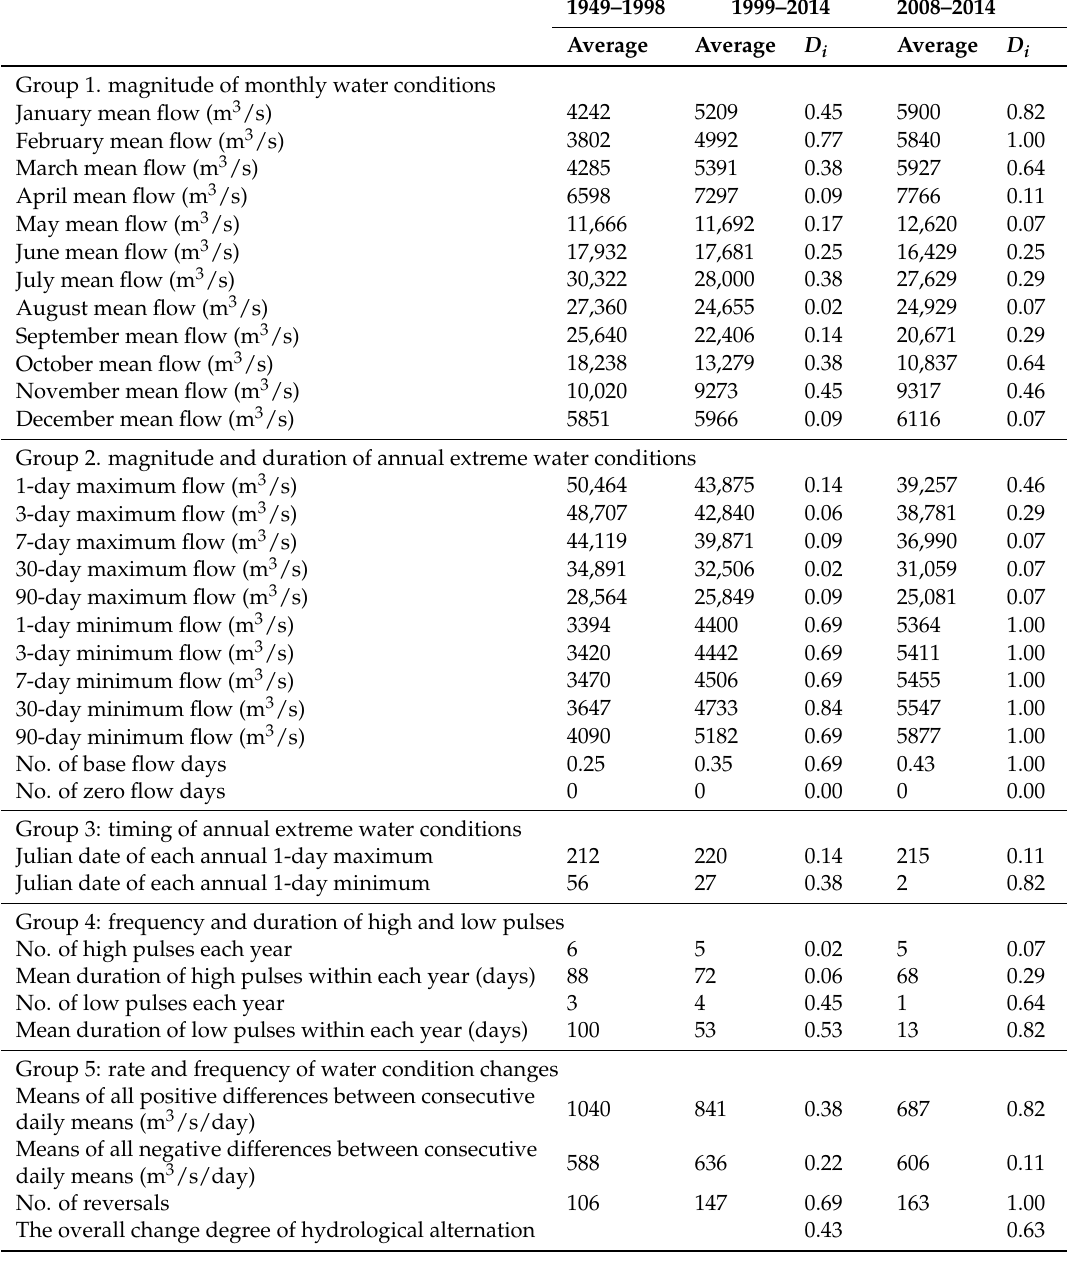
Table 4. Results of IHA change degree indicators under different periods at Yichang